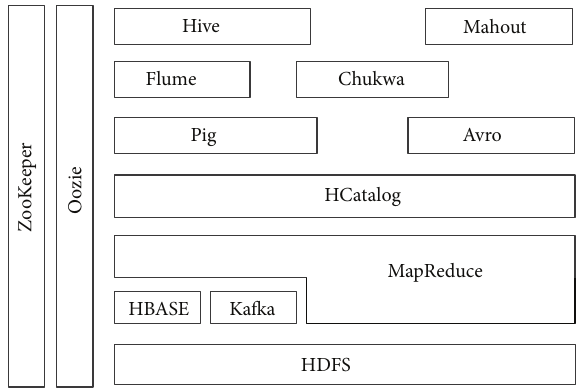
Figure 3: Hadoop